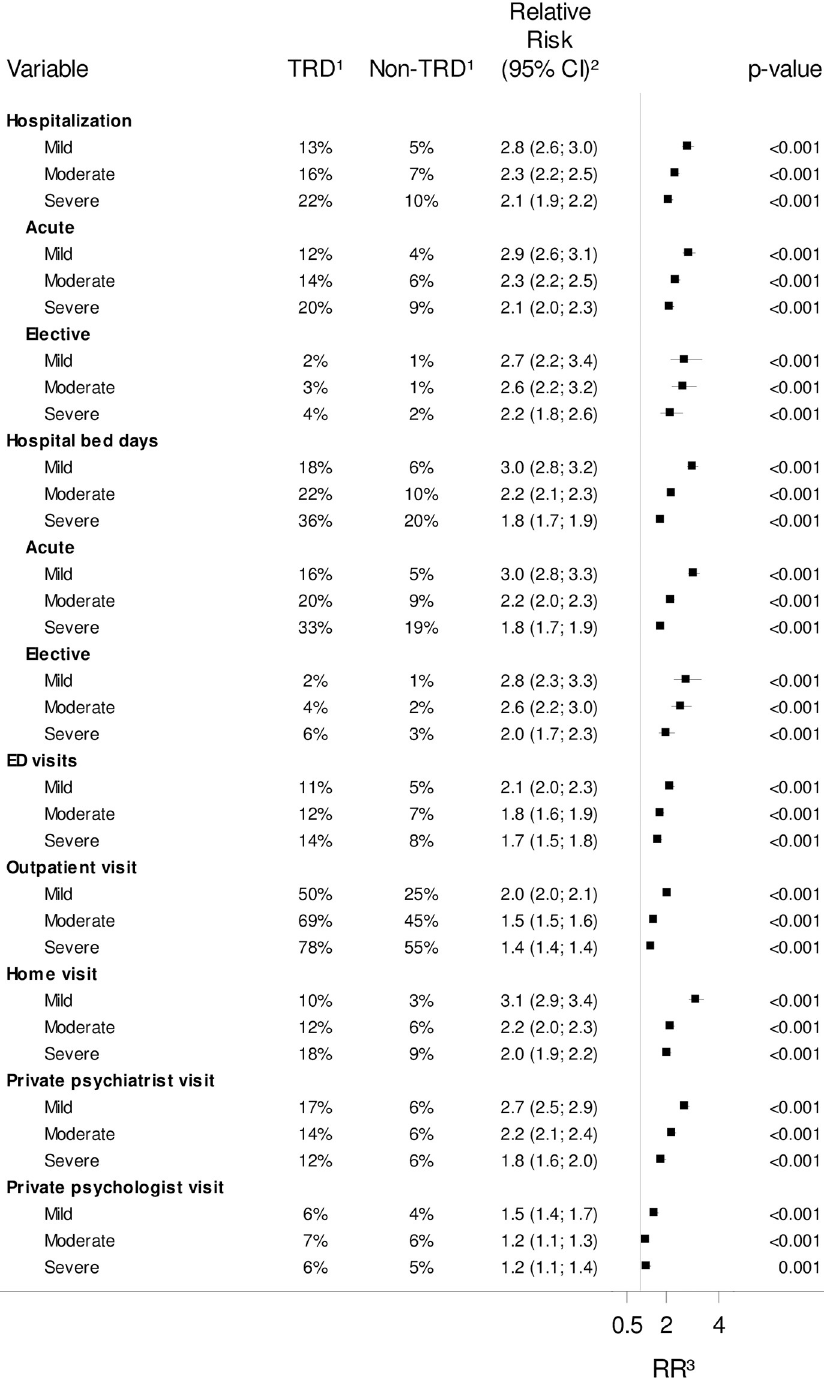
PLOS ONE | https://doi.org/10.1371/journal.pone.0275299 September 27, 2022 10 /